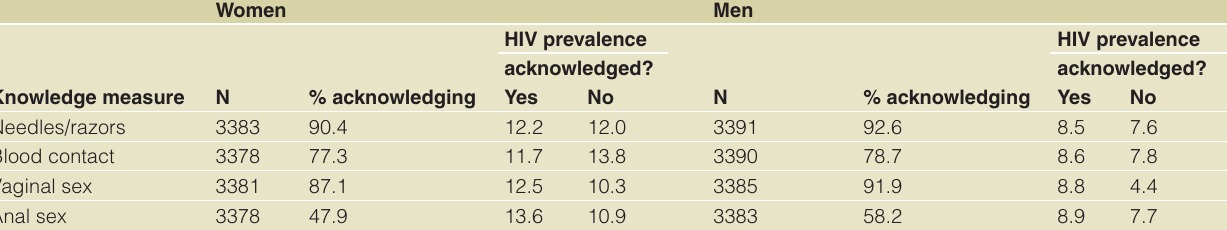
Table 1. Knowledge of specific HIV transmission modes and relationship with prevalent HIV infection, Mozambique,